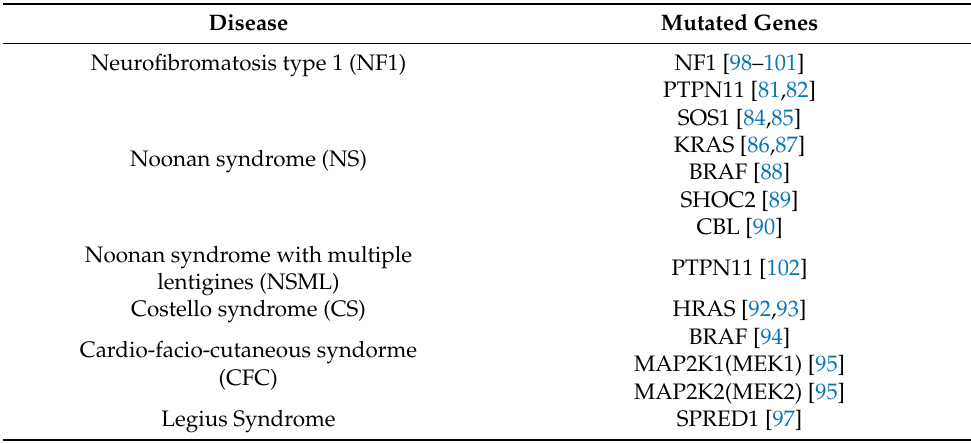
Table 1. Genes involved in